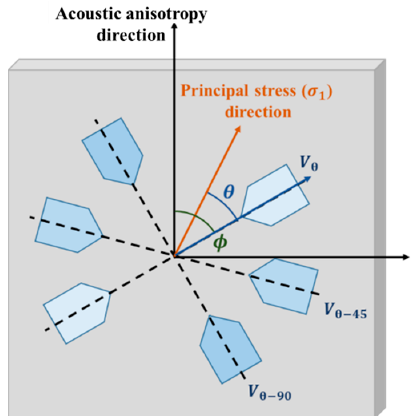
Figure 2. Principal stress ( σ 1 ) direction, and three-measuring directions in 45° increments, in which θ is the angle from a measuring direction to the principal stress ( σ 1 ) direction and ϕ is the angle to the anisotropy direction, and V θ , V θ− 45 , V θ− 90 are surface wave velocities propagating in the θ , θ − 45°, and θ − 90° directions, respectively.